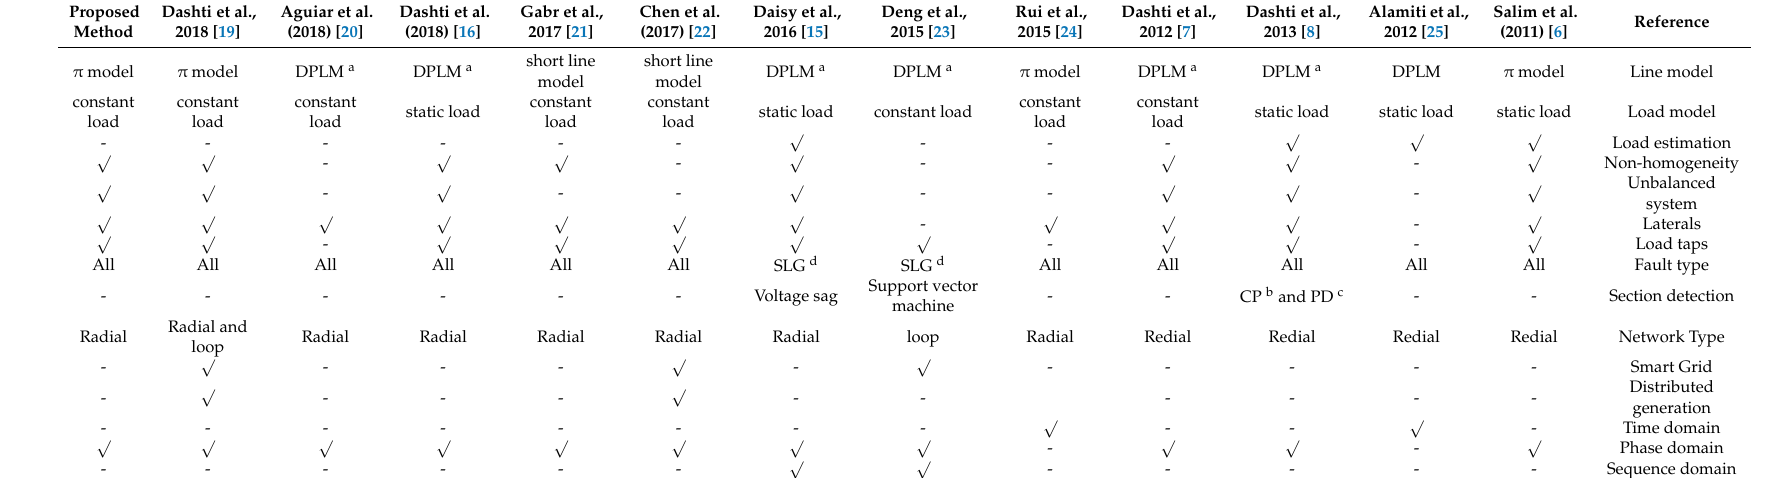
Table 1. Comparison of different power distribution fault-location